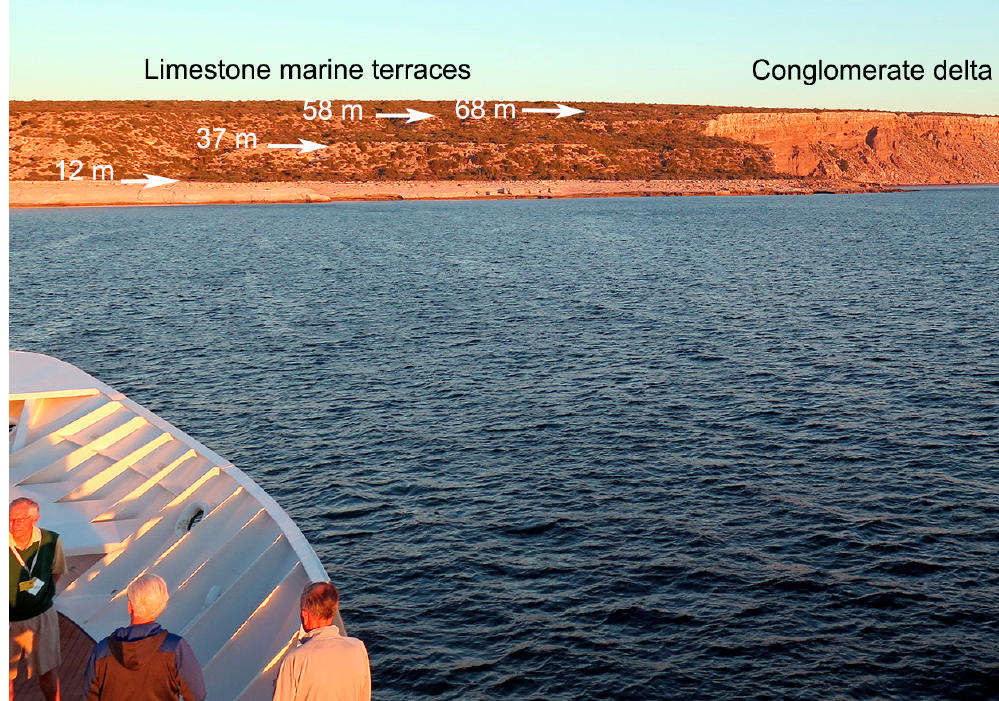
Figure 2. View from the sea showing a stretch of the rocky coast along the east side of Isla del Carmen with adjacent lithologic facies represented by the Pliocene Tiombó mega-delta (right) and Pliocene limestone secondarily eroded with Pleistocene marine terraces at four levels.